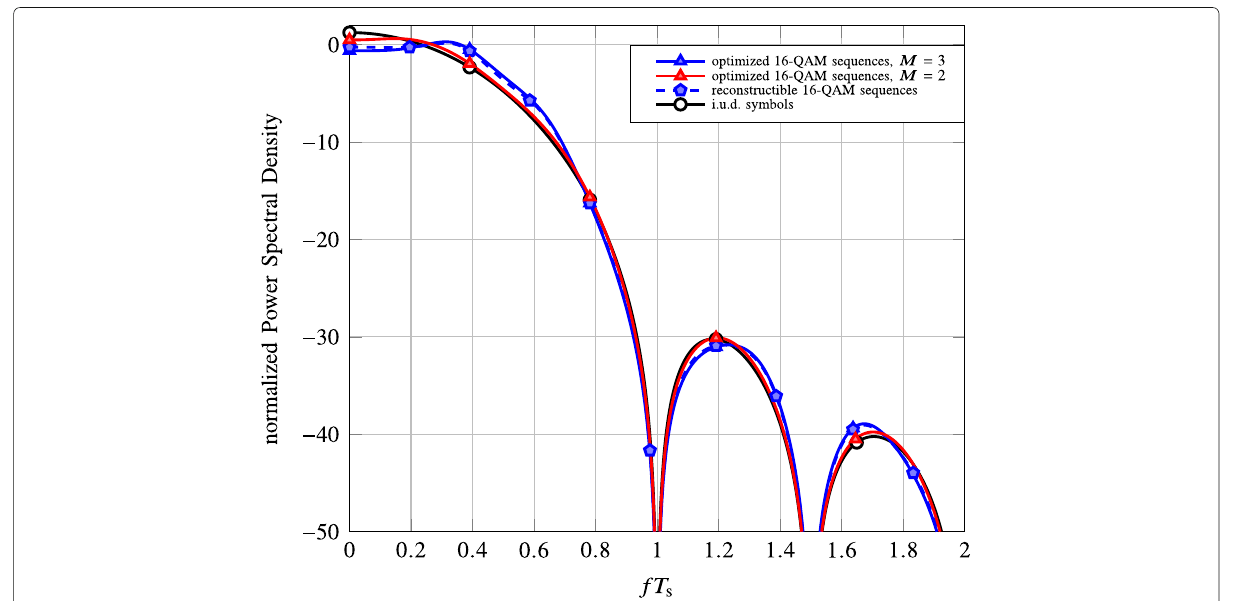
Fig. 10 Power spectral density for different sequence designs based on cosine transmit pulses